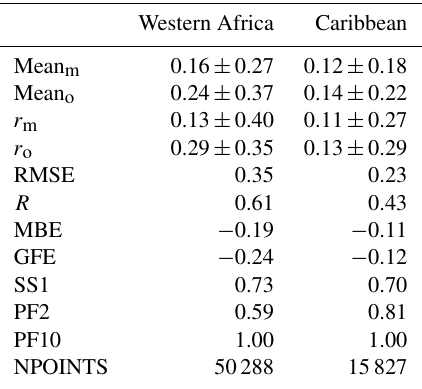
Table 2. The long-term EMAC model evaluation for the AOD from 2000 to 2012. Statistics are given for both sides of the Atlantic based on the selected AERONET sites around western Africa and the Caribbean (station average). The evaluation metrics are defined in Appendix A, while the station locations are shown in Fig. 3.